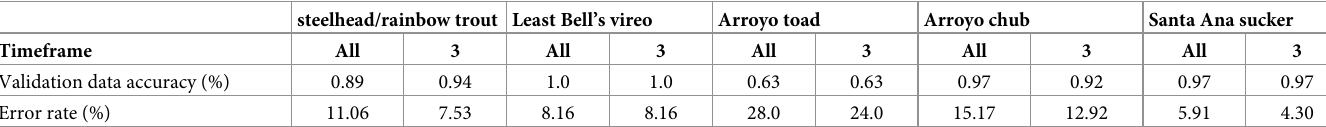
Table 5. Comparison of the two random forest models that used the all-year vs 3-year predictor variables. steelhead/rainbow trout Least Bell’s vireo Arroyo toad Arroyo